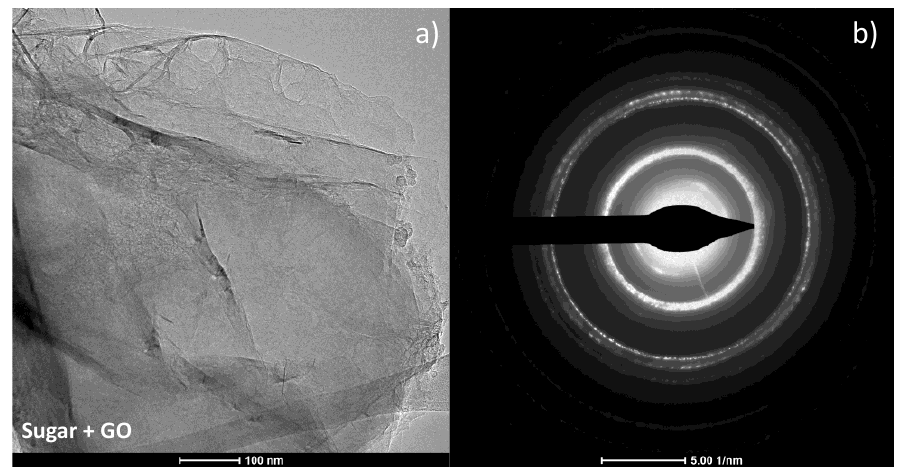
Figure 6. ( a ) HRTEM image and ( b ) corresponding SAED pattern for the single-phase sugar + GO C-C composite.